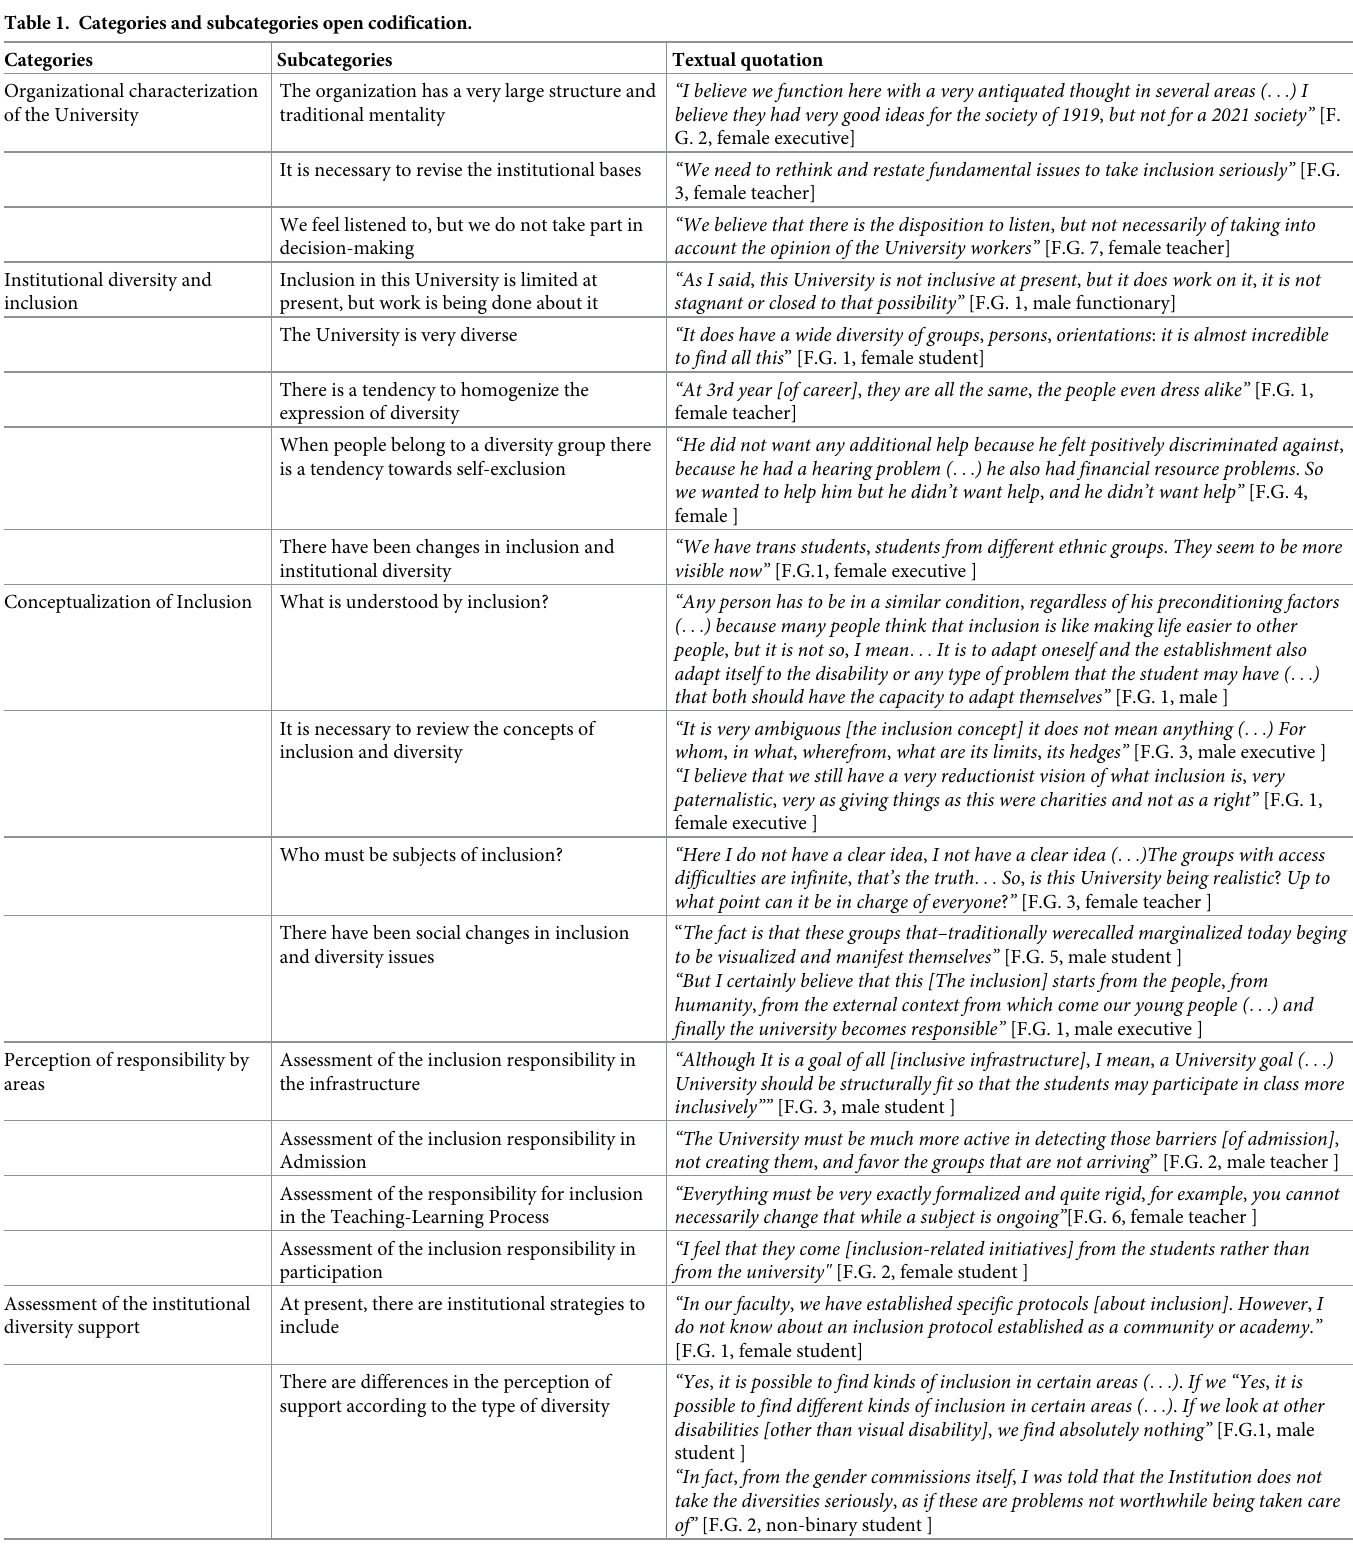
Table 1. Categories and subcategories open